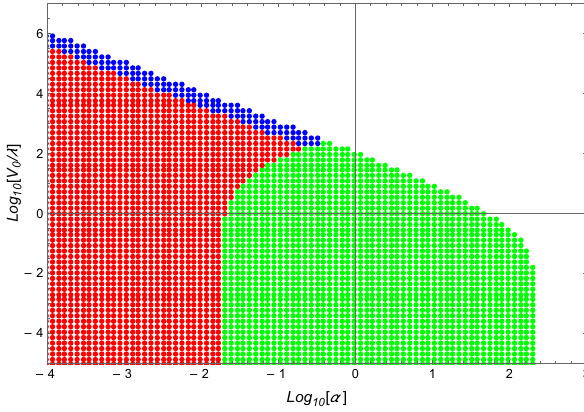
Fig. 3 The marginalized 1 σ and 2 σ confidence level contours for n s and r from Planck 2018 and BICEP2 results [19,20] and the numerical results for the E-models with n = 1 in brane inflation. In the left panel, the cyan dashed line lies at about r ≈ 10 − 4 . 17 which is the sufficient but not necessary upper limit for (cid:6)φ < 1, and the inset shows the small